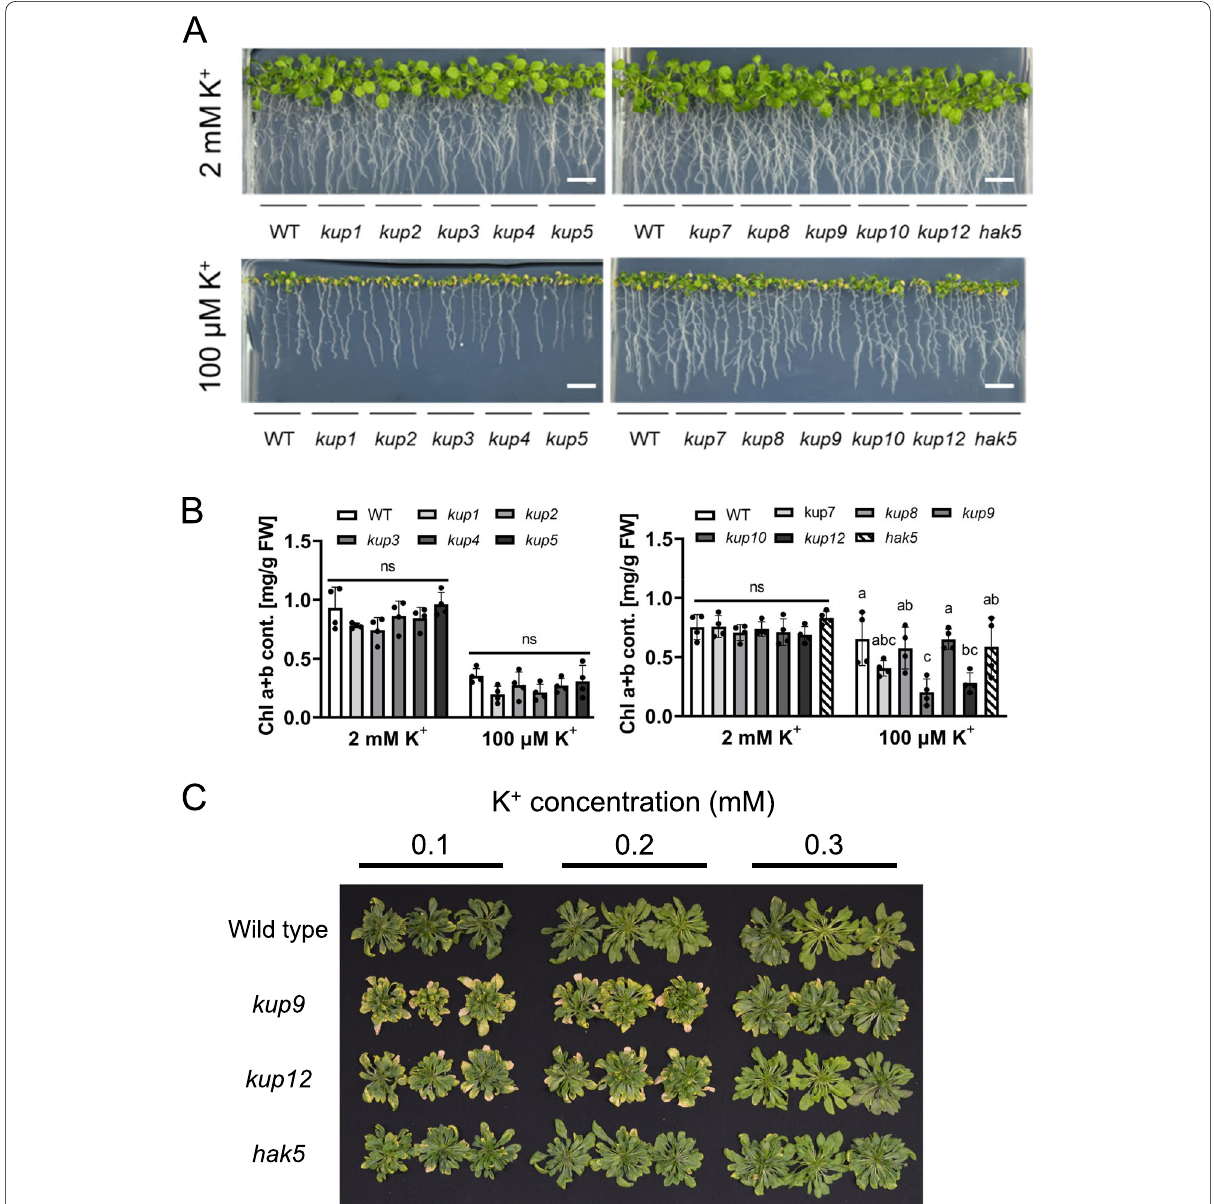
Fig. 2 Phenotypes of kup/hak/kt mutants under low K + and K + sufficient conditions. A Photograph of two-week-old plants grown on medium containing 2 mM (top) or 100 μM K + (bottom). B Chlorophyll content of the shoot tissue of the same plants. Data are shown as mean n 4 independent plants . * P < 0.05, ns, not significant ( P > 0.05); one-way ANOVA. Scale bar = different amounts of KCl. Representative images of 63-day-old wild-type, kup9 kup12 and hak5 plants, grown for the last 30 days on hydroponic medium containing 0.1, 0.2 or 0.3 mM